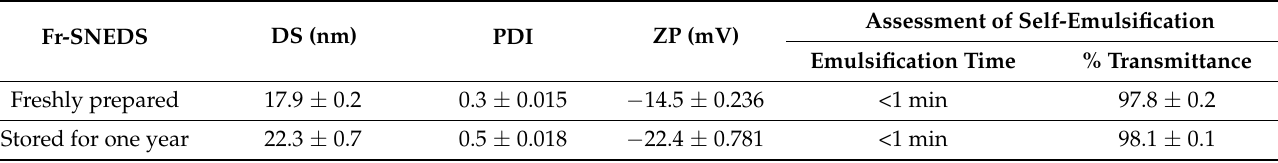
Table 7. The physicochemical parameters for fresh and stored Fr-SNEDS. Data are expressed as mean ± SD ( n = 3).